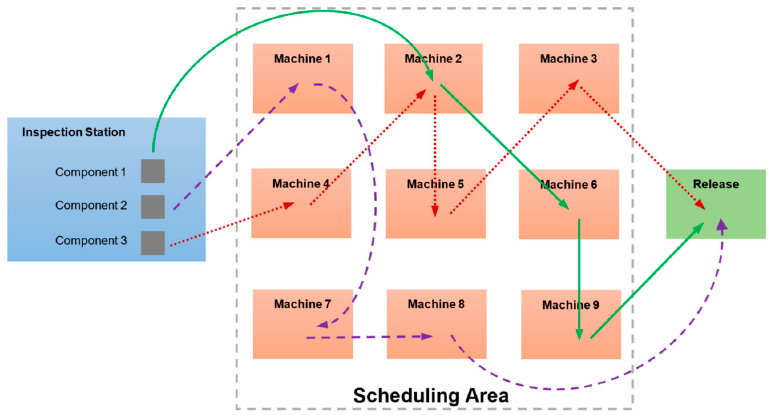
Figure 1. Illustration of Maintenance, Repair, and Overhaul (MRO) processes.